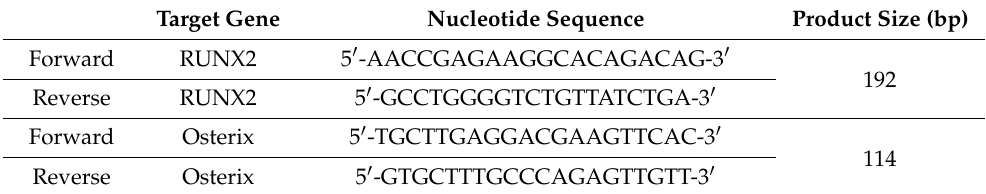
Table 1. Primer sequence for detecting mRNA expression. Target